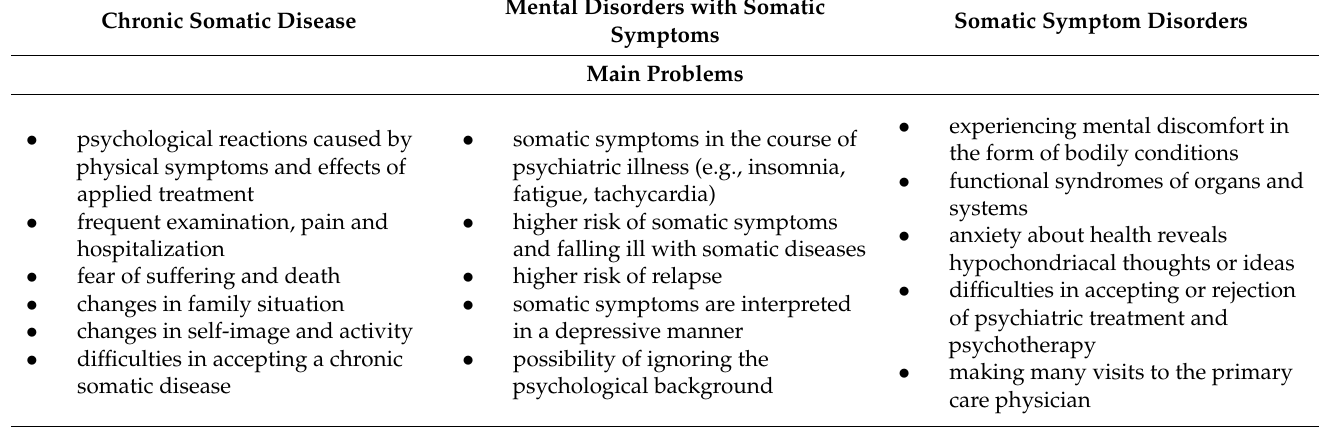
Table 1. The relationship between psyche and body in the psychotherapeutic process. Chronic Somatic